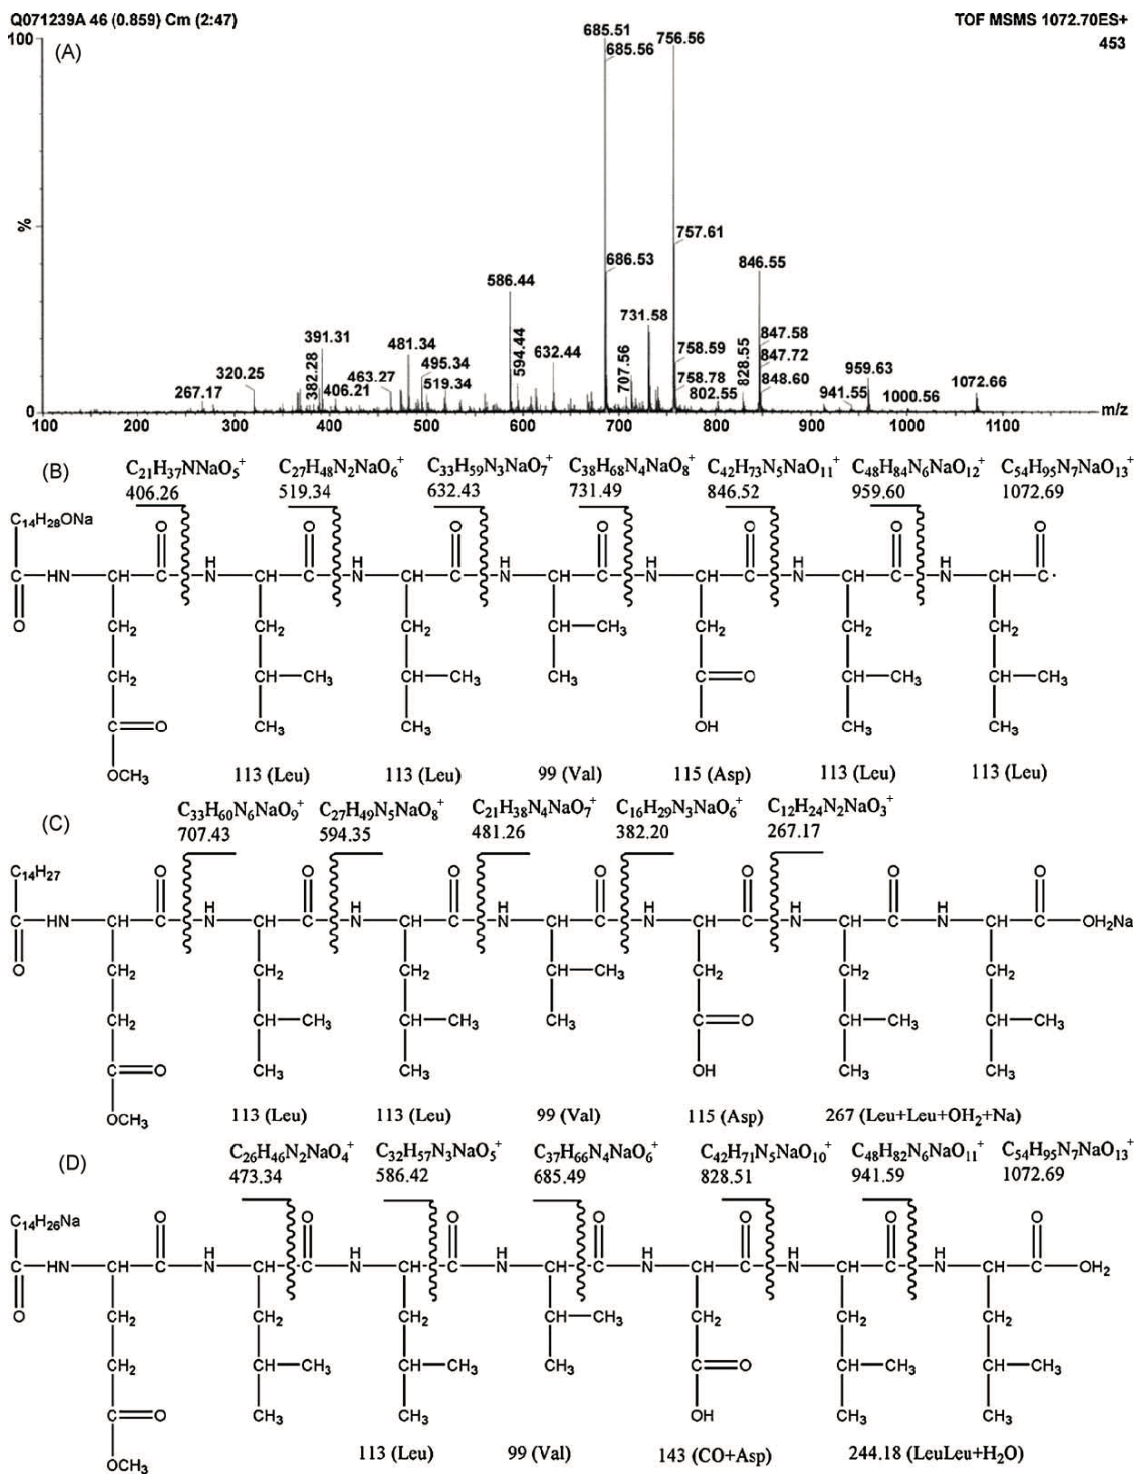
Figure 1. Tandem MS of C15-surfactin-O-methyl ester ( A ) TOF MS/MS; ( B ) Fragment ions after simple cleavage; ( C , D ) fragment ions produced after the double hydrogen transfer of lipopeptides in TOF MS/MS. Reprinted from Process Biochem 44: 1144 [23]. Copyright (2009), with permission from